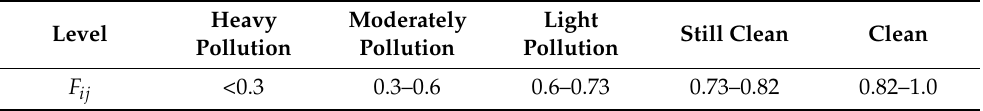
Table 5. Soil quality